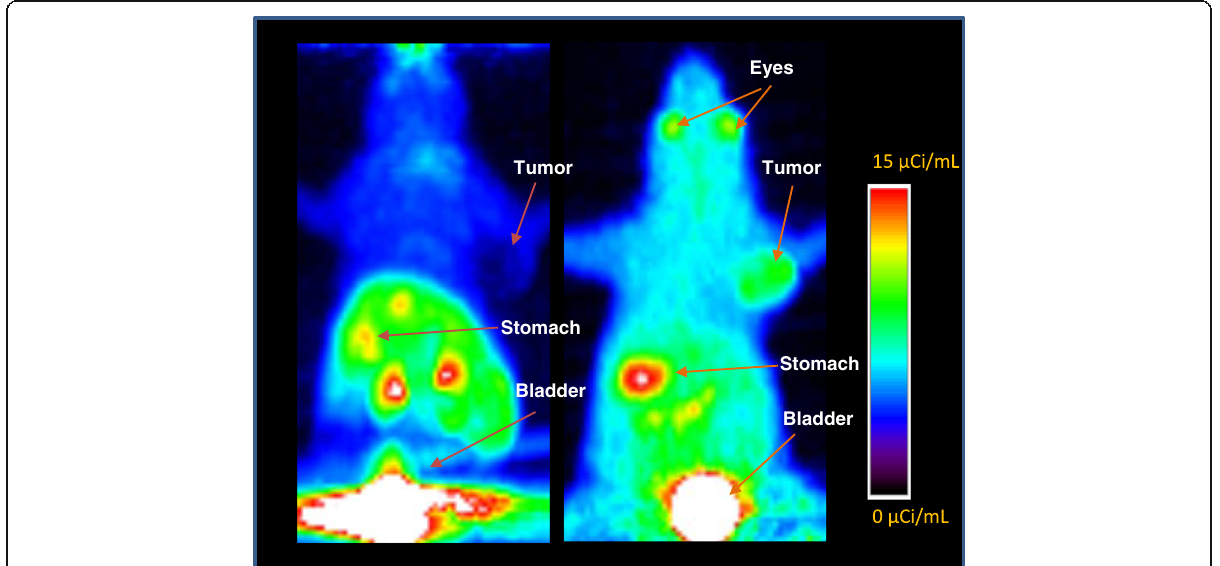
Fig. 7 Maximum intensity projection (MIP) image from MicroPET scans of mice bearing B16F1 melanoma ( right panel ) and HT-29 human colorectal ( left panel ) tumor xenograft. An intense uptake of radioactivity is seen in B16F1 tumor. In contrast, HT 29 tumor shows a significantly low uptake and it is quite difficult to visualize this tumor on microPET images ( left panel ). Eyes show a distinct uptake pattern in B16F1 tumor bearing mice ( right panel ). Additionally, the uptake of radiotracer in skin of black mice (C57/BL6) was evident from darker background ( right panel ) in comparison to lack of such uptake in the skin for HT-29 tumor bearing athymic mice ( left panel )